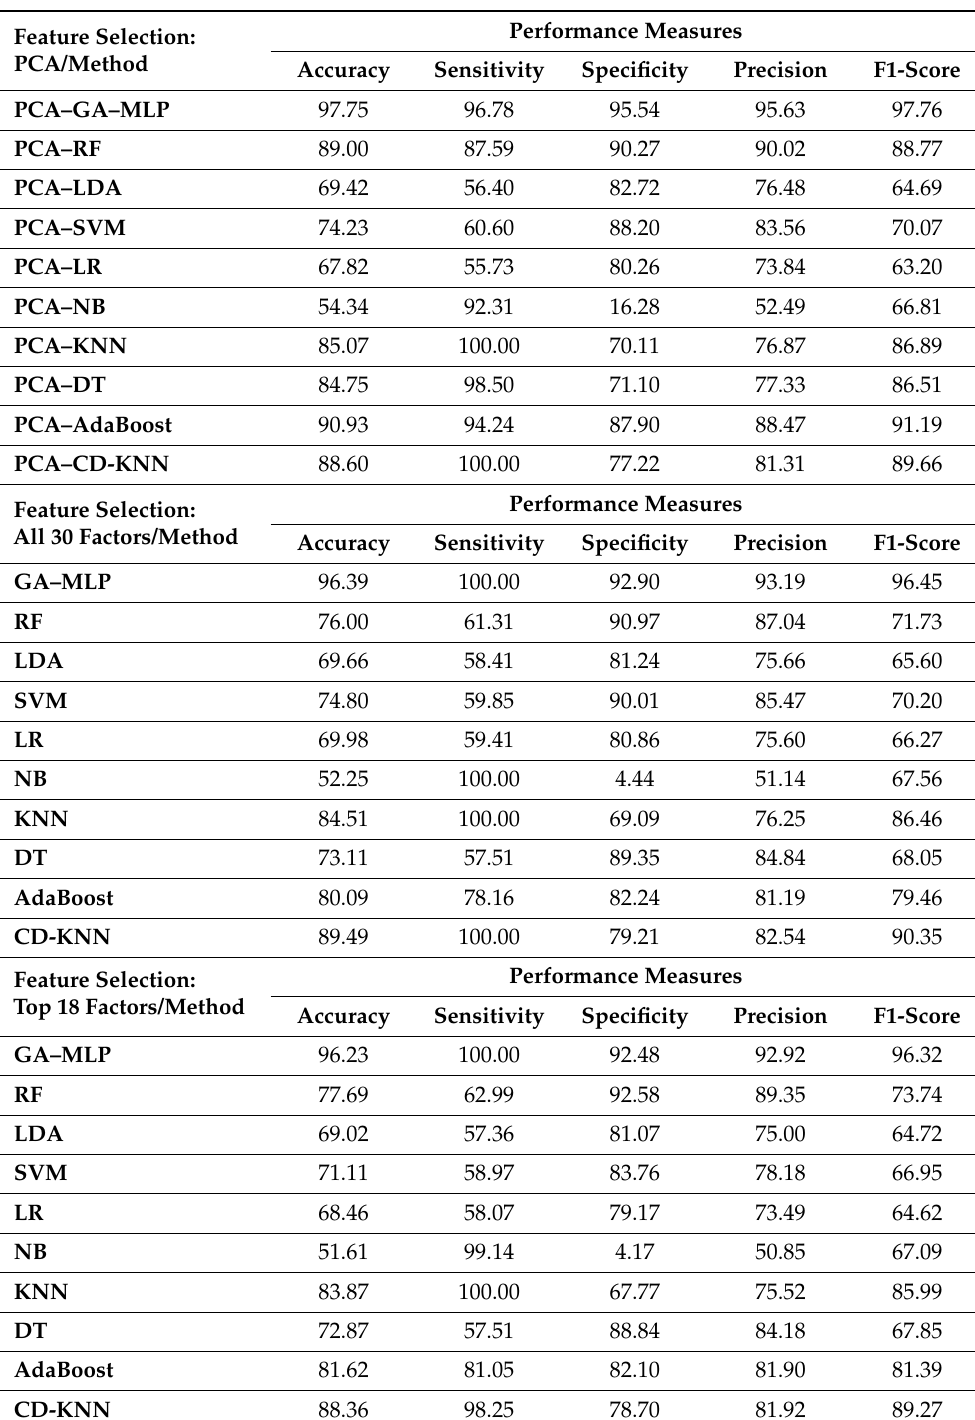
Table 11. Comparison of the proposed method using four feature selection methods with nine other classification algorithms in diagnosing